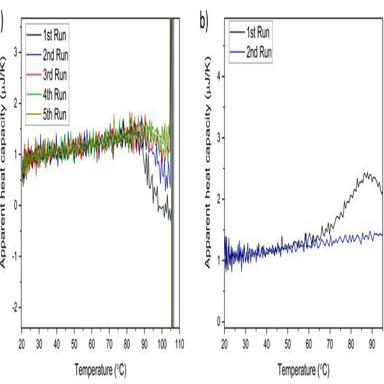
Nanocalorimetry of PEI/MCM-41. (a) multiple thermal cycles measured in UHP CO2 after the sample was activated in vacuum; (b) two consecutive thermal cycles measured in vacuum after the thermal cycles in UHP CO2. Note: a dip in the apparent heat capacity curve indicates an exothermic event (adsorption) and a bump suggests an endotherm event (desorption).